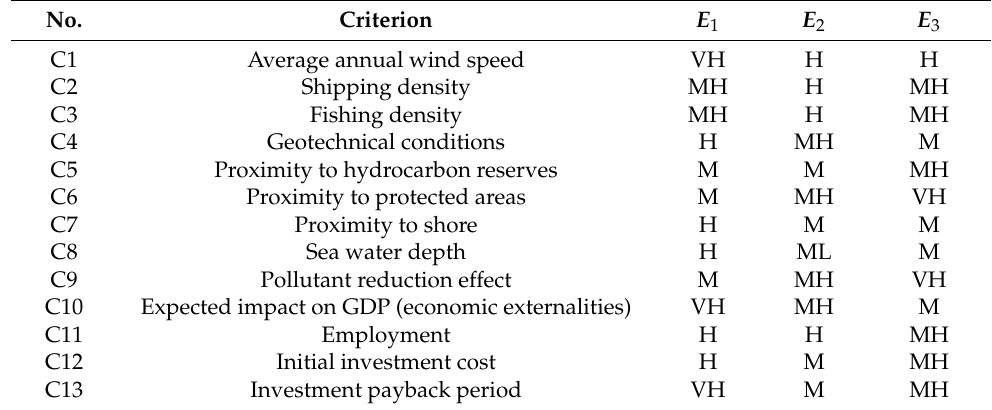
Table 2. Criteria weights assigned by individual stakeholders.